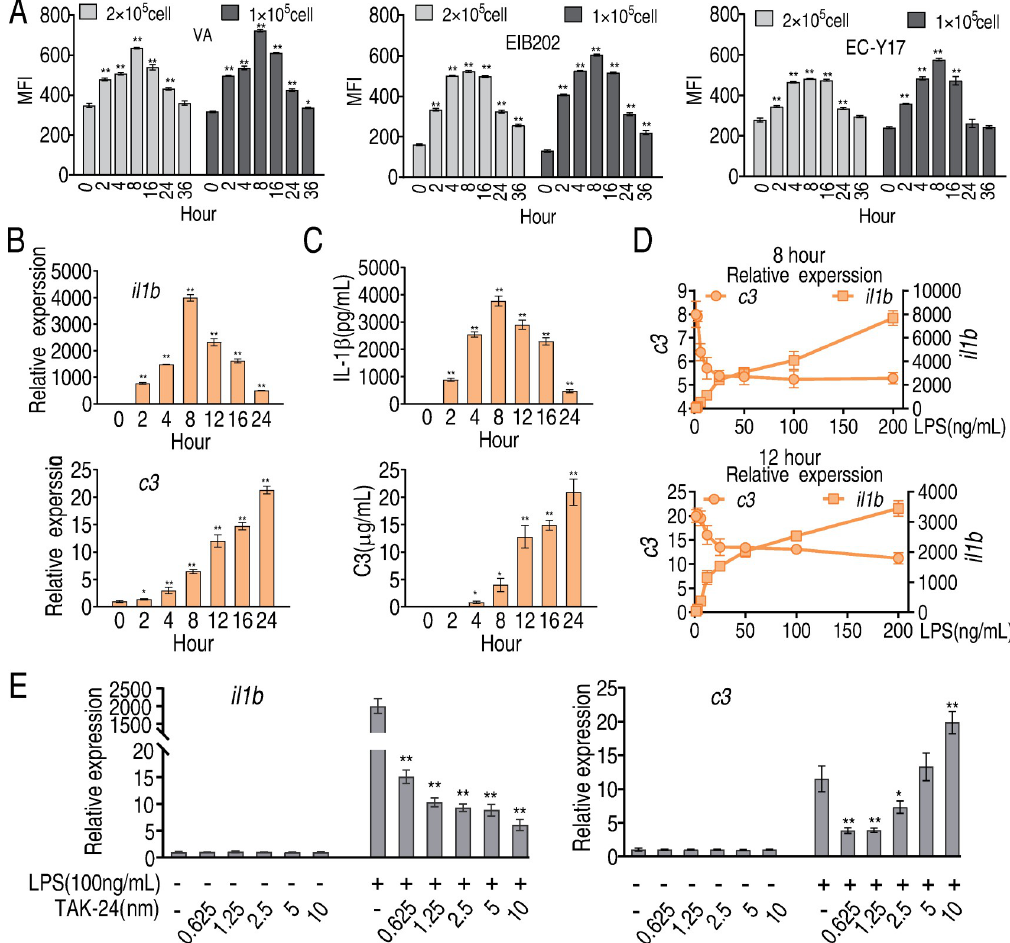
Fig 1. Phagocytosis, IL-1 β and C3 in LPS-stimulated macrophages. A, Phagocytosis of FITC-labeled V . alginolyticus (VA), E . tarda (EIB202), or E . coli (Y17) by LPS-treated RAW264.7-asc cells. Cells were analyzed by flow cytometry and phagocytosis was estimated from mean fluorescence intensity at the indicated time points after LPS-stimulation. Three biological replicates were performed at each time point. B, Transcription of il1b and c3 was estimated by qRT-PCR at the indicated time points after LPS stimulation. C, IL-1 β and C3 were quantified in extracellular media by ELISA at the indicated time points after addition of LPS. D, Transcripts of il1b and c3 were quantified by qRT-PCR in cells exposed for 8 or 12 h to the indicated concentration of LPS. E, Transcripts of il1b and c3 were quantified in cells treated with 100 μ g LPS. TLR4 Inhibitor TAK-24 at the indicated concentration, or LPS plus TLR4 inhibitor. Results (B-E) are displayed as mean ± SEM, and significant differences are identified ( � p < 0.05, �� p < 0.01) as determined by non-parametric Kruskal-Wallis one-way analysis with Dunn multiple comparison post hoc